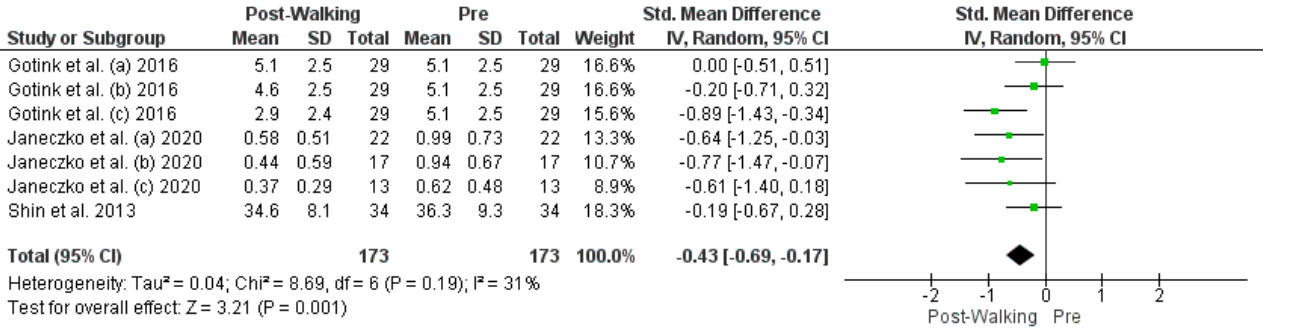
Figure 3. Anxiety Post- vs. Pre-walk Forest Plot [12–14]. Green squares represent standardized mean difference for each study, while black rhombus represents the aggregated average of the standardized mean differences.